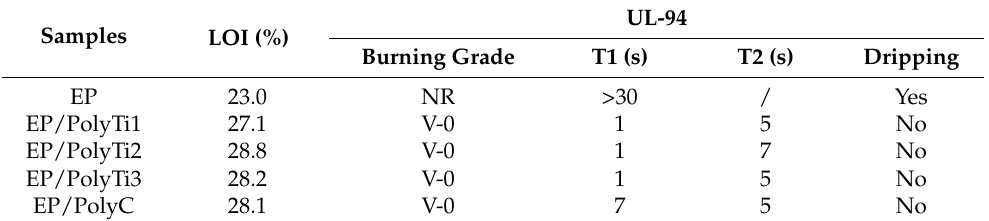
Table 3. The LOI value and UL-94 test of the EP composites with 5 wt% addition. Samples LOI (%)